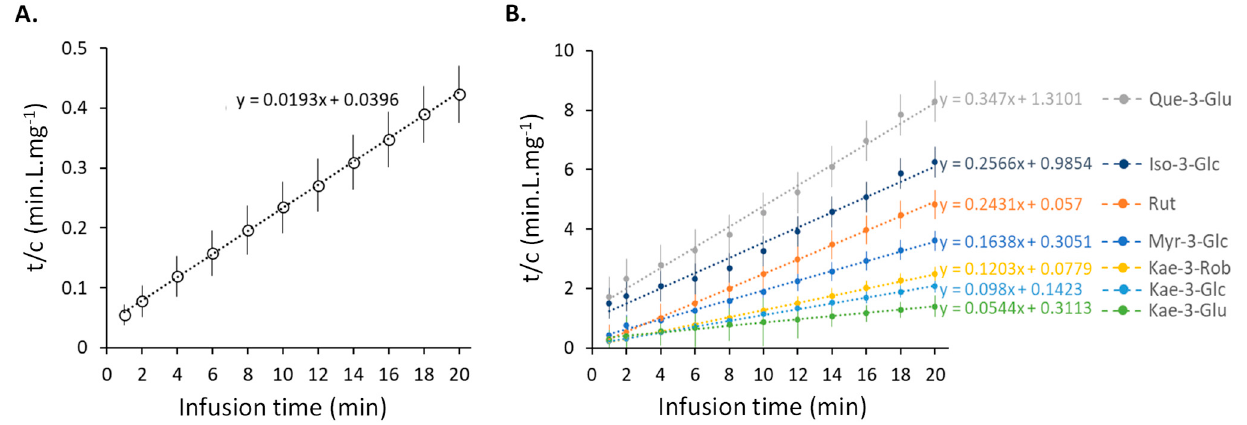
Figure 3. Correlation between t/C and extraction time for total flavonoids ( A ) and the main individual flavonoids ( B ) from sacred lotus stamen tea infusion. Table 1. Kinetic parameters for the extraction of the flavonoids from sacred lotus stamen tea infusion. C ∞